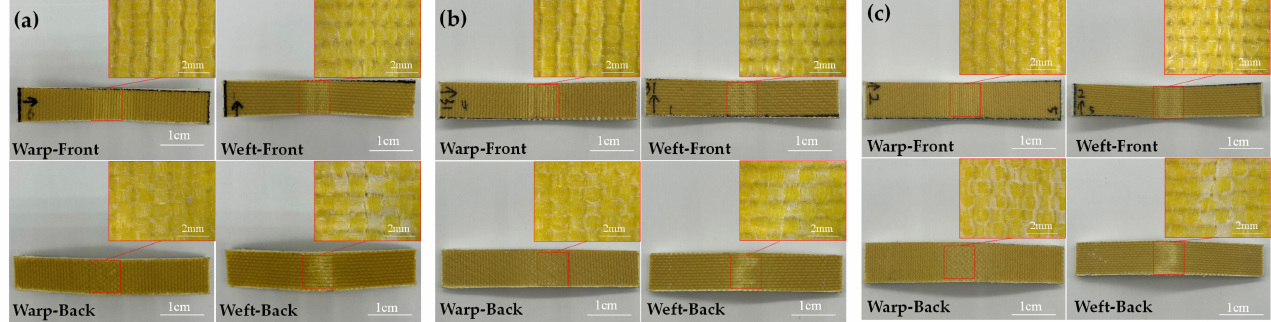
Figure 7. Destruction morphologies of 3D armor materials under different weft